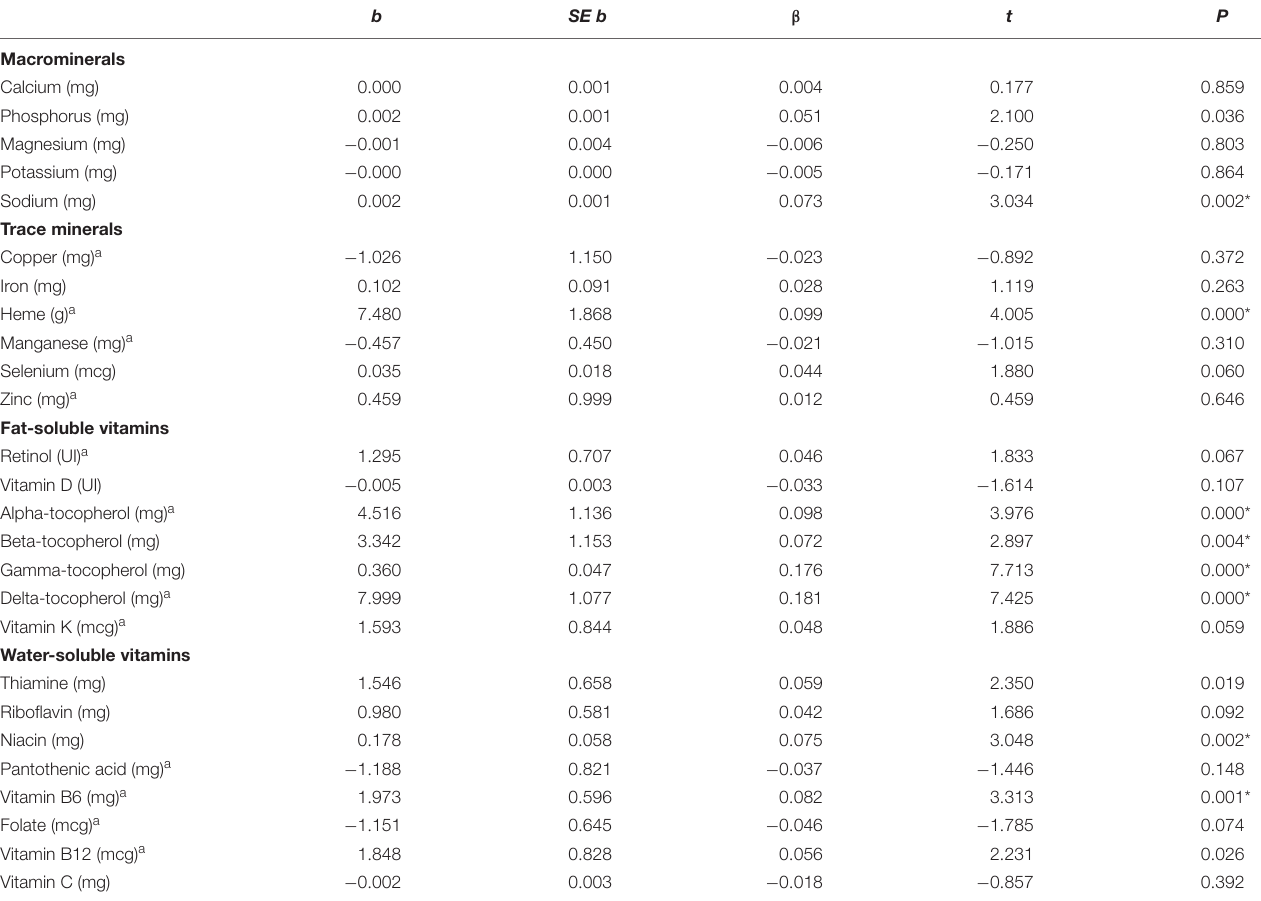
TABLE 4 | Linear regressions between each micronutrient and recollection accuracy (%).